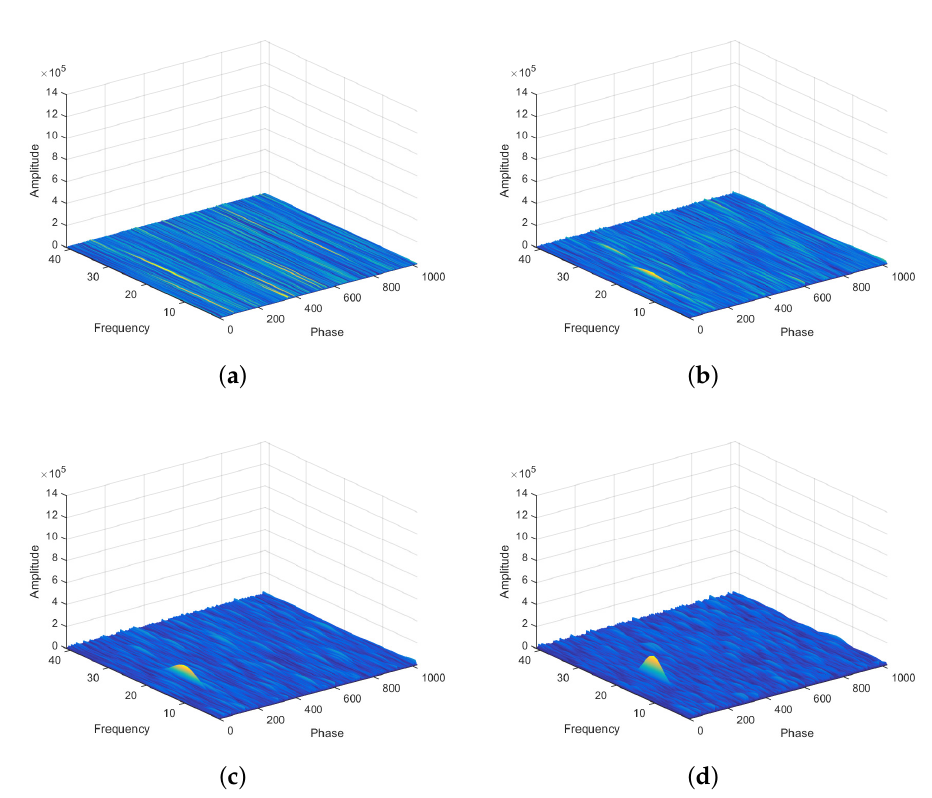
Figure 4. Illustration of the values of a correlation matrix for a satellite search after 4 consecutive rounds of 1023 samples, with the number of samples increasing from ( a – d